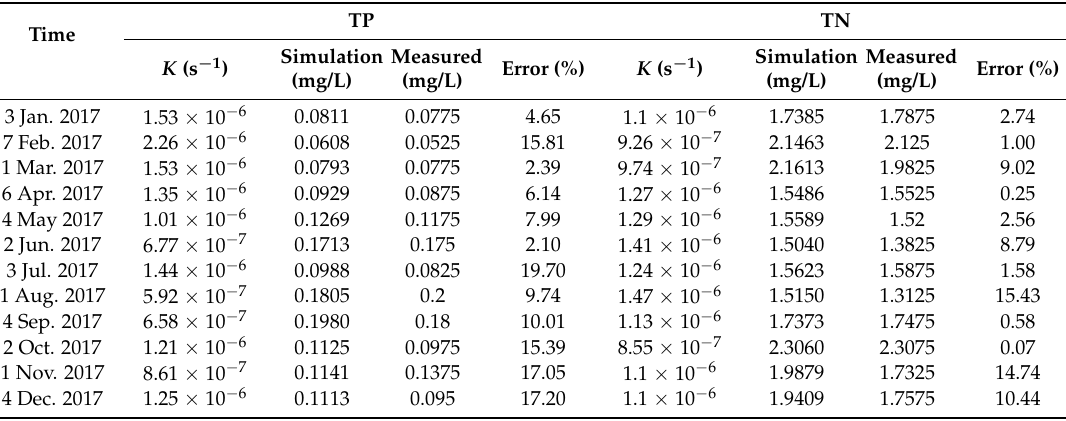
Figure 6. Model (water quality) validation of Xuanwu Lake in 2017. Table 1. Error analysis table.